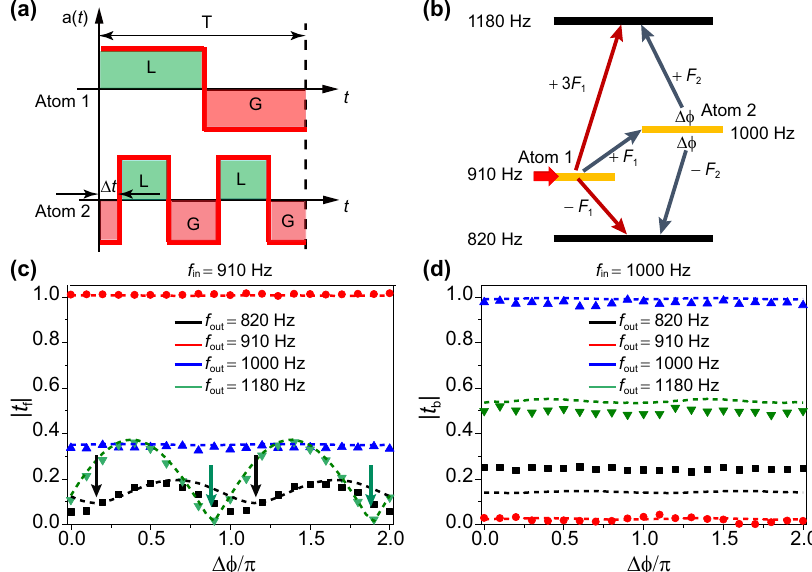
Fig. 4 Analogy of quantum interference with design capability. a The schematic of amplitude modulation for two time-varying meta-atoms, where atom 2 has doubled modulation frequency ( F 2 ¼ 2 F 1 ¼ 180Hz) and an additional modulation time delay Δ t . b The “ energy-level ” diagram for two time-varying meta-atoms with asymmetric frequency coupling. c Forward transmission amplitude j t f j spectra for input frequency at 910 Hz. d Backward transmission j for input frequency at 1 kHz, with the interference “ turned off ” . In c and d , symbols represent the experimental results, dashed lines represent amplitude j t b the numerical simulation results, and arrows in c indicate the dip positions predicted from destructive interference conditions (see details in Supplementary Note